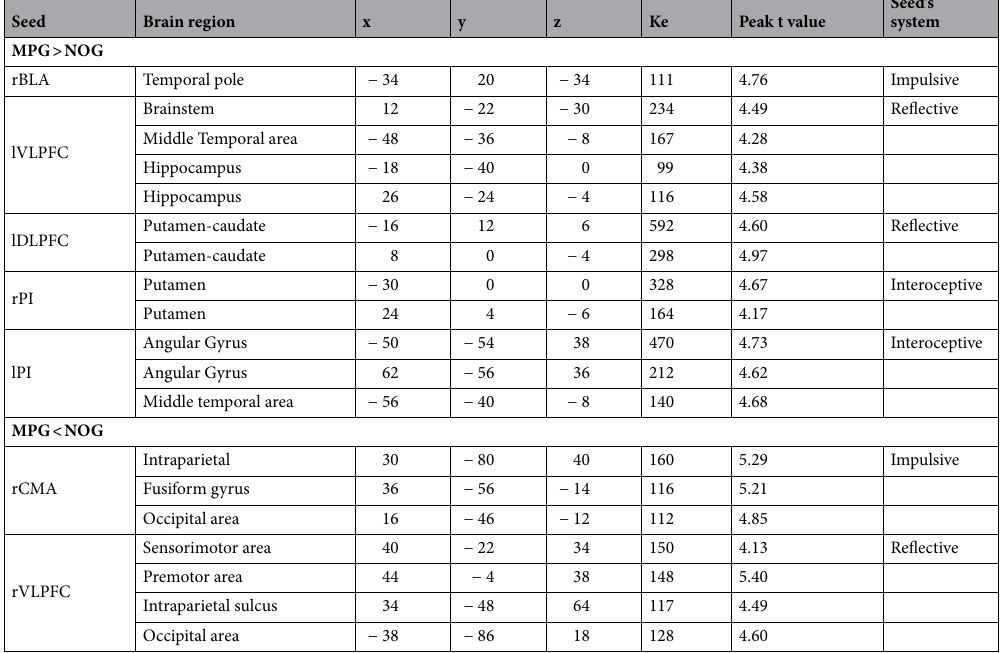
Table 2. Significant differences between MPG and NOG in seed-based functional connectivity. Coordinates (x, y, z) are given in Montreal Neurological Institute atlas space (MNI). Ke cluster size in voxels; All the results have exceeded the minimum threshold p < 0.001 and number of voxels for each seed, Seed’s system system to which each seed corresponds according to the Triadic reflective–impulsive–interoceptive awareness model, MPG male perpetrators group, NOG non-offenders group, rBLA right basolateral amygdala, lVLPFC left ventrolateral prefrontal cortex, lDLPFC left dorsolateral prefrontal cortex, rPI right posterior insula, lPI left posterior insula, rCMA right centromedial amygdala, rVLPFC right ventrolateral prefrontal